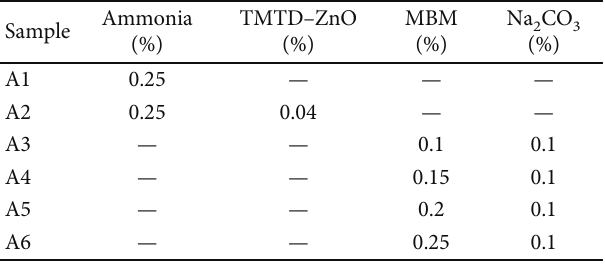
Table 3: Optimized formula of concentrated NRL preservation